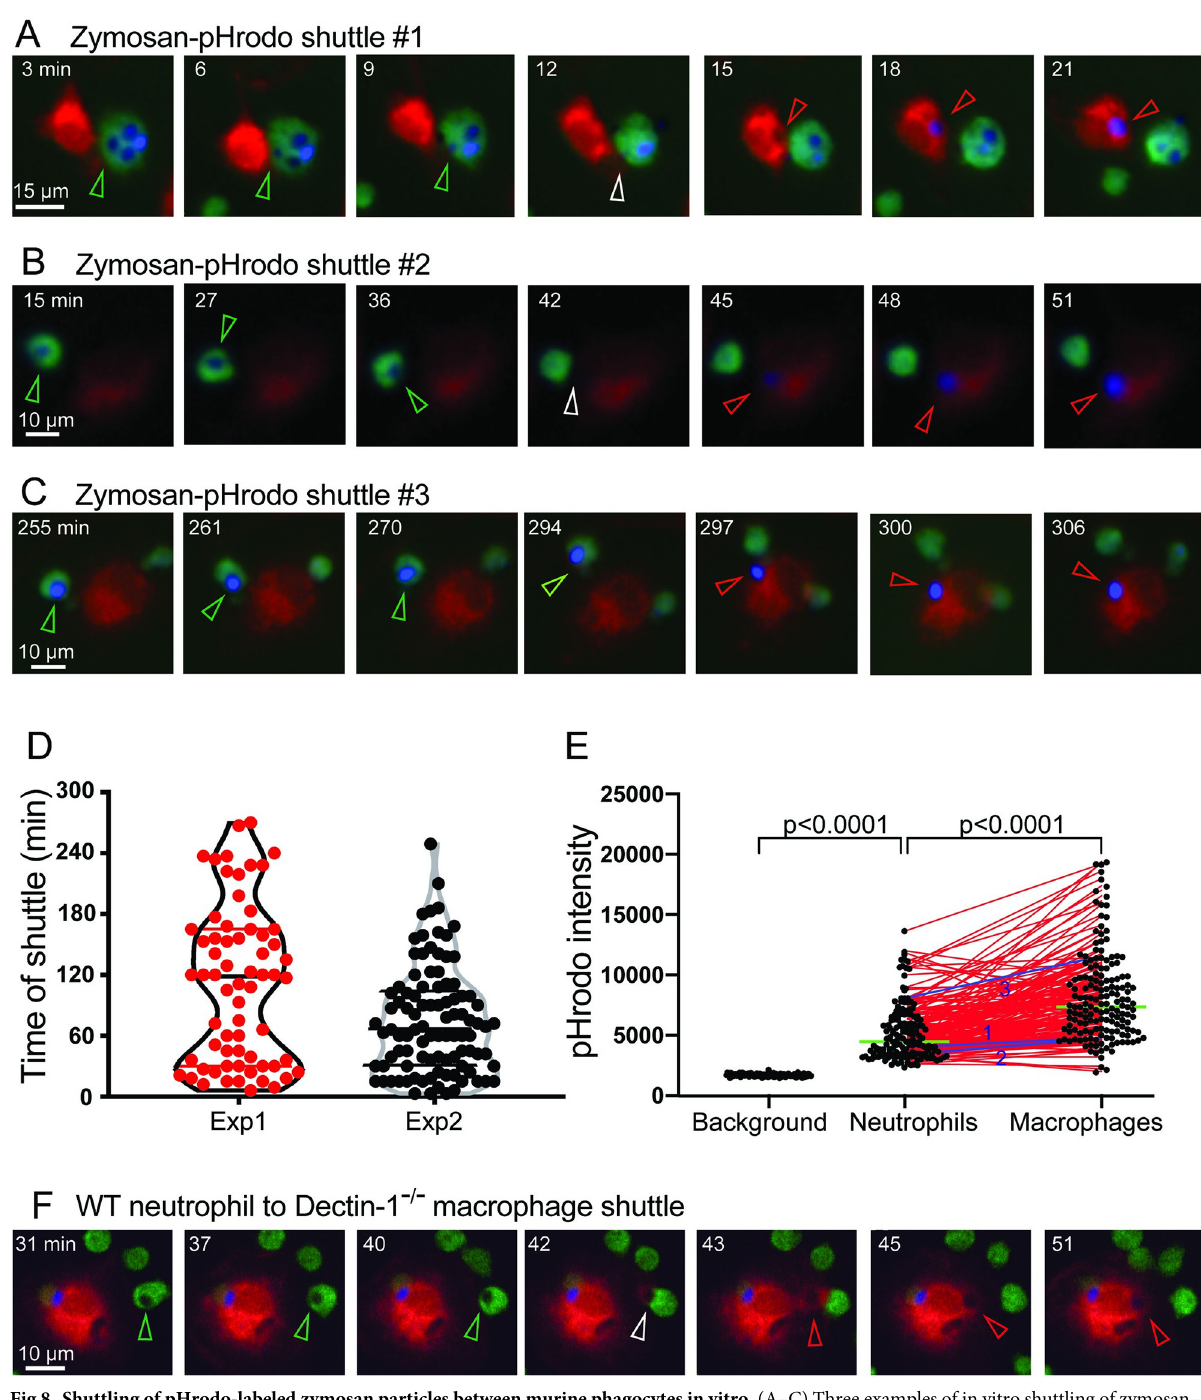
Fig 8. Shuttling of pHrodo-labeled zymosan particles between murine phagocytes in vitro. (A–C) Three examples of in vitro shuttling of zymosan– pHrodo particles, representative of 164 shuttling events. Neutrophils, green; macrophages, red; pHrodo–zymosan, false-colored blue. Scales as shown. Stills from S6C–S6E Movie. (D) Distribution of the time of shuttling for 164 in vitro shuttling events in panel C and S2 Table (Experiment 1, n = 66; Experiment 2, n = 98). (E) pHrodo signal intensity (arbitrary units) for in vitro shuttled zymosan–pHrodo particles ( n = 164). Background intensity is for n = 100 randomly selected points clearly positioned between cells ( n = 50 from each experiment). Black dots show the distributions of zymosan– pHrodo intensities in neutrophils 6 min before shuttling and in macrophages 6 min after shuttling; red lines connect paired values. p -values from unpaired two-tailed t test (background versus neutrophil) and paired two-tailed t test (neutrophil versus macrophage). Green line indicates median. Blue lines (1–3) correspond to the 3 examples shown in panels A–C. (F) Example of in vitro shuttling of a zymosan–pHrodo particle from a wild-type